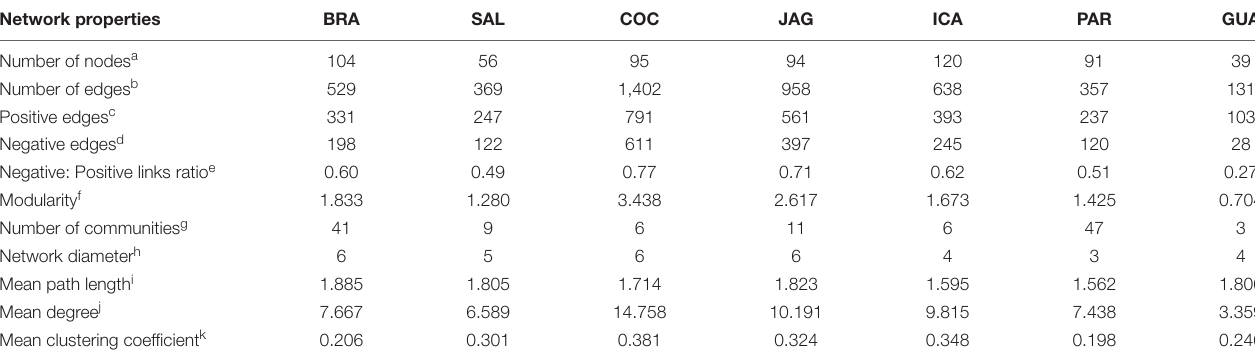
TABLE 1 | Topological measures of Rhizophora mangle root-zone microbiome co-occurrence networks in seven Brazilian mangroves [BRA = Bragança (N); SAL = Salinópolis (N); COC = Cocó (NE); JAG = Jaguaribe (NE); ICA = Icapuí (NE); GUA = Guaratuba (S); and PAR = Paranaguá (S)]. Network properties BRA SAL COC JAG ICA PAR GUA Number of nodes a